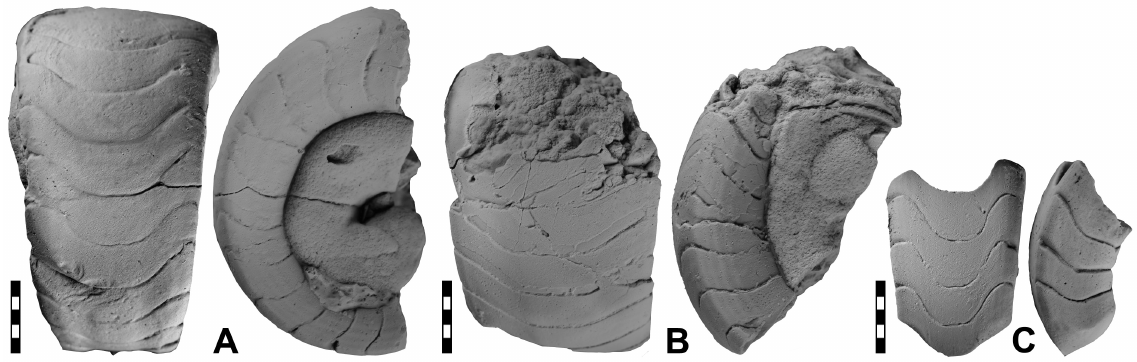
Fig. 18. Vestinautilus inflexus sp. nov. from Oued Temertasset (both Korn et al . 2002 Coll.). A . Paratype MB.C.30472.2. B . Holotype MB.C.30472.1. C . Paratype MB.C.30472.3. Scale bar units = 1 mm.